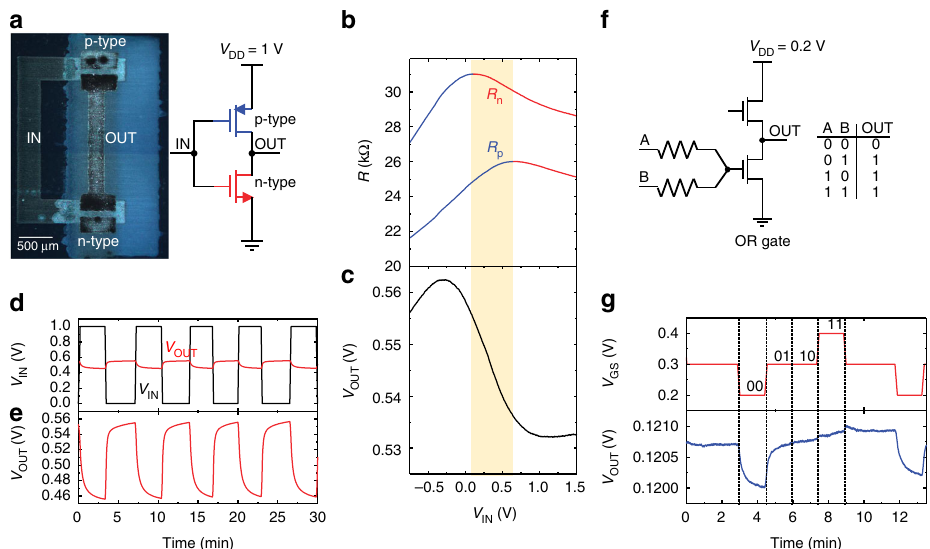
Fig. 6 Fully inkjet-printed logic. a Optical microscopy image (dark fi eld) of an integrated circuit demonstrating an all inkjet-printed complementary graphene inverter as shown in the schematic. b The measured resistances of the top ( R p ) and bottom ( R n ) GFET as a function of the input voltage. Segments of the curves displaying n -type ( p -type) behaviour are drawn in red (blue). c The measured static voltage transfer characteristic of the printed inverter. The inverter is capable of signal inversion between the maximum and minimum of the transfer characteristic. d , e Digital V IN black) and V OUT (red) waveforms measured on one of the fabricated inverters at V DD = 1 V under ambient conditions. f Circuit diagram of a multifunctional printed logic gate with two inputs (A and B) and one output (OUT) with truth table of an OR logic gate. g Digital waveforms measured in an OR logic gate. The gate voltage V GS takes three discrete levels labelled by the values of the corresponding Boolean variables A and